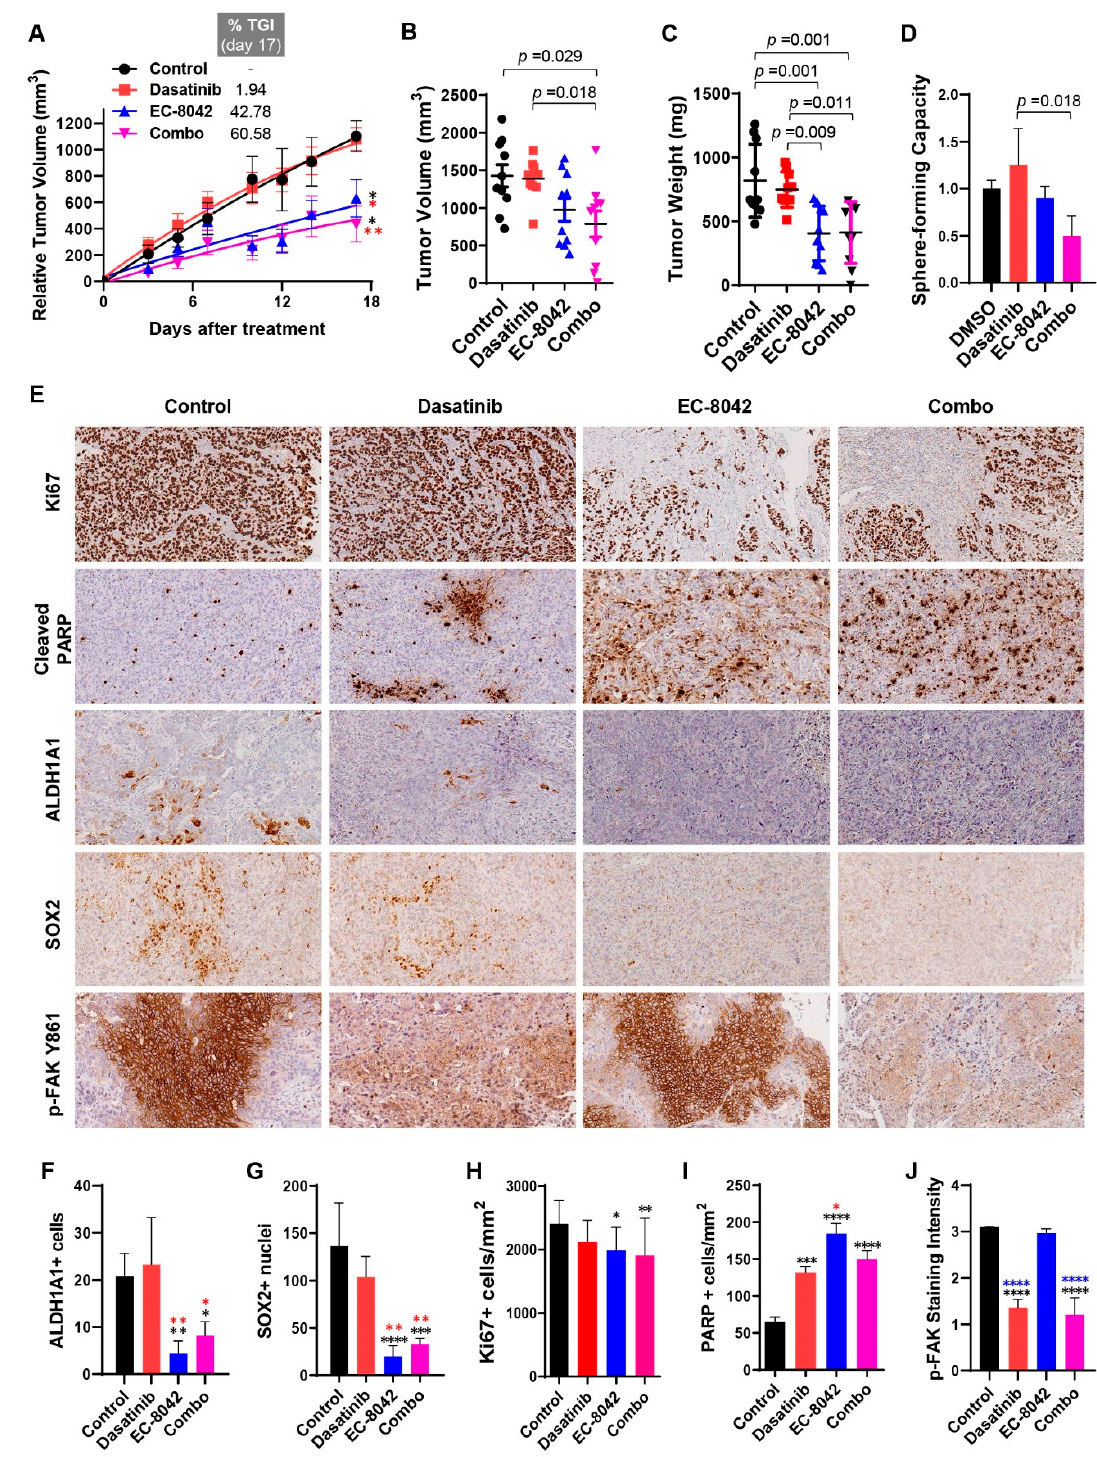
Figure 5. Effect of combination treatment with dasatinib and EC-8042 in FaDu xenografts. Mice with established FaDu xenografts were randomly assigned to four different treatment groups ( n = 10 tumors per group) and treated with saline buffer intravenously (i.v.) and/or tartaric acid (orally) (control), dasatinib (orally) at a dose of 10 mg/Kg every day (16 doses), EC-8042 (i.v.) at a dose of 50 mg/Kg every 7 days (4 doses), or the dasatinib plus EC-8042 combination (combo). Animals were sacrificed 4 h after the last treatment with dasatinib and 24 h after treatment with EC-8042. ( A ) Curves representing the mean tumor volume of FaDu xenografts during the treatments. Drug efficacy expressed as the percentage of tumor growth inhibition (%TGI) at the end of the experiment is indicated. Mean ± SD ( n = 10 per treatment group), RM-one-way ANOVA, Tukey’s test, * p < 0.05, **